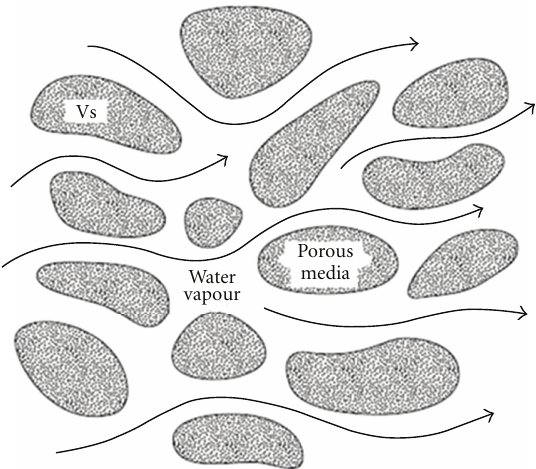
Figure 9: A typical domain of a porous medium two phase